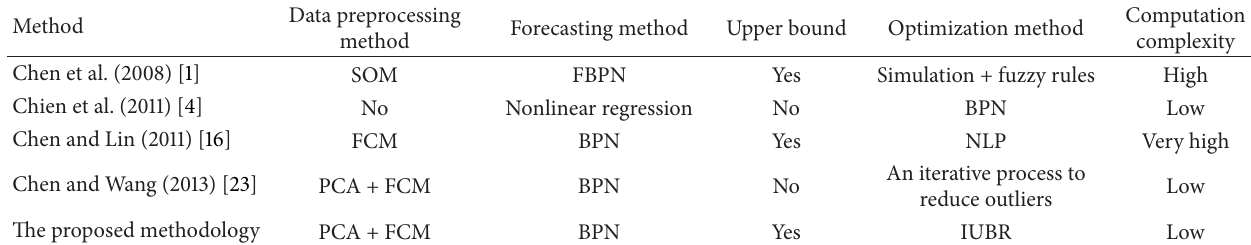
Table 1: The differences between this study and some recent references.